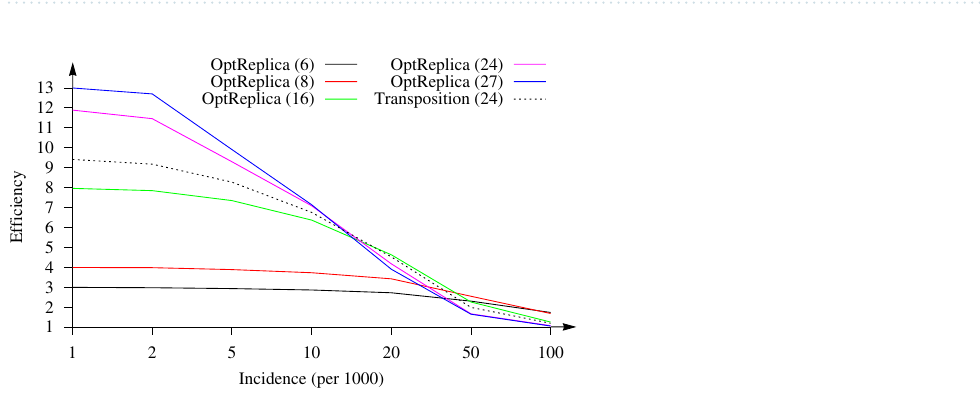
Table 2. Efficiency of OptReplica and the transposition based replication testing 384 samples. The best results for each incidence vale are marked in bold.